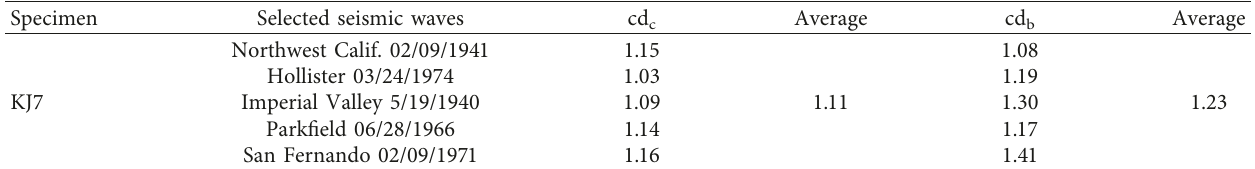
Table 25: Maximum curvature ductility coefficients of beams and columns in model KJ7.